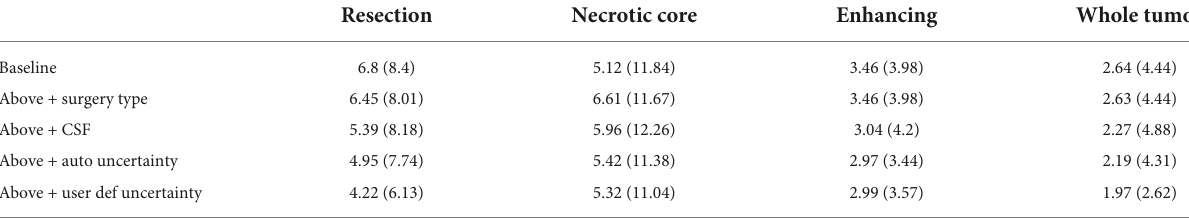
TABLE 1B A comparison of mean surface distance (mm) for three glioblastoma multiforme (GBM) tissues and for the entire tumor segmented as one tissue.